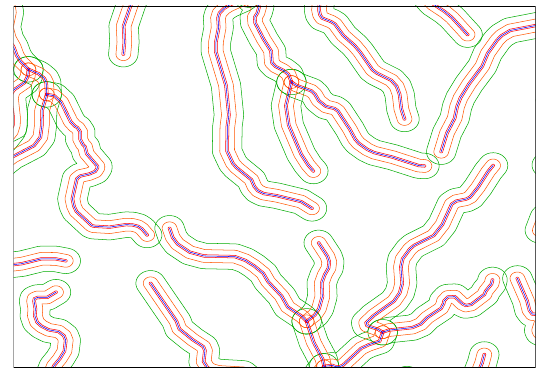
Figure 4: Buffers of 100m (red), 500m (orange) and 1000m (green) around rivers (blue) in the southern region of